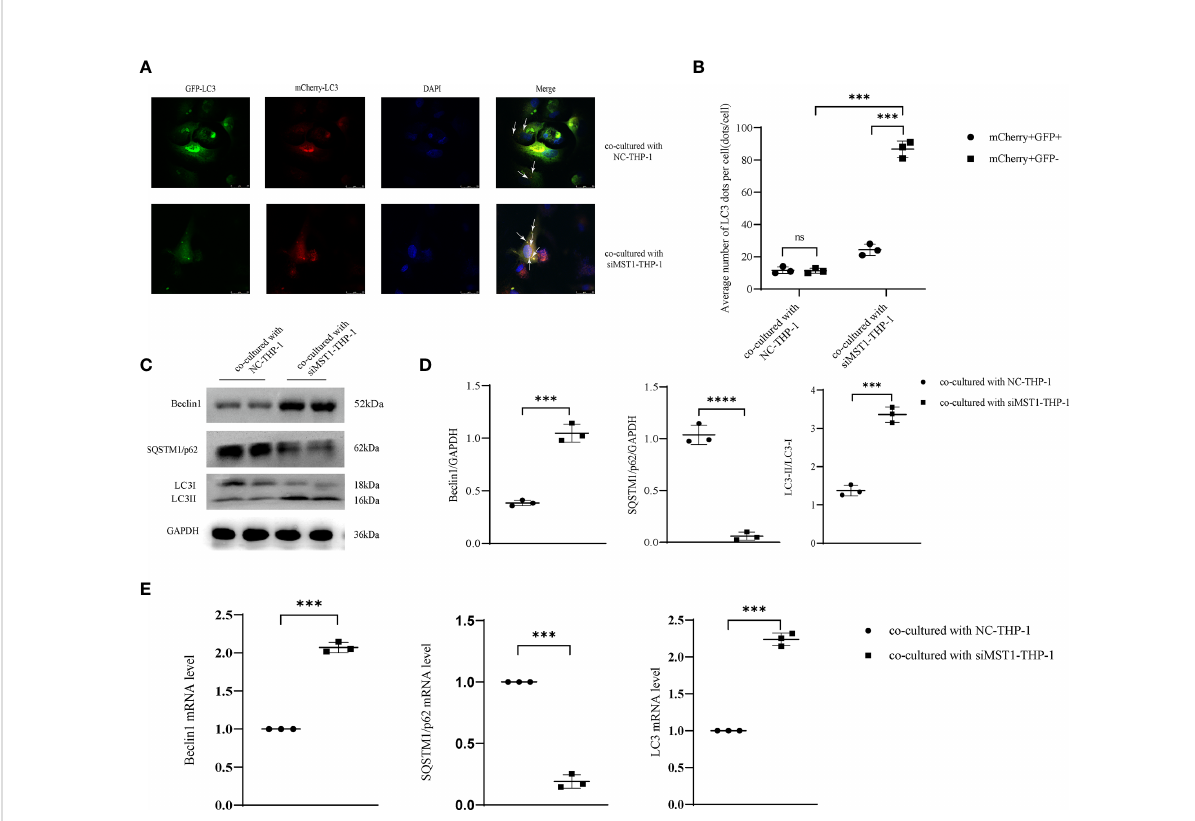
FIGURE 5 MST1 knockout from macrophages induced HESC autophagy by co-culture. (A, B) HESCs co-cultured with siRNA- MST1 -THP-1, and then mCherry- GFP- LC3 adenovirus was transduced into HESCs to evaluate the autophagy fl ux. (C, D) The representative images of protein expression of autophagic genes in HESCs co-cultured with siRNA- MST1 -THP-1 by western blot. (E) The mRNA level of autophagic genes in HESCs co-cultured with siRNA- MST1 -THP-1 by RT-PCR. ***P < 0.001, ****P < 0.0001, ns means not statistically signi fi cant. Values represent the mean ± standard